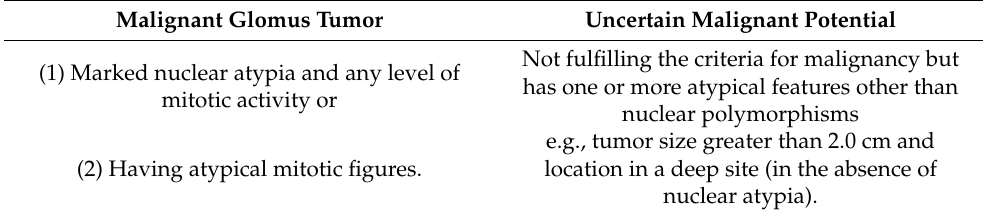
Table 1. WHO classification of glomus tumors (5th edition, 2020) 1 . Malignant Glomus Tumor Uncertain Malignant Potential Not fulfilling the criteria for malignancy but (1) Marked nuclear atypia and any level of has one or more atypical features other than mitotic activity or nuclear polymorphisms e.g., tumor size greater than 2.0 cm and (2) Having atypical mitotic figures. location in a deep site (in the absence of nuclear